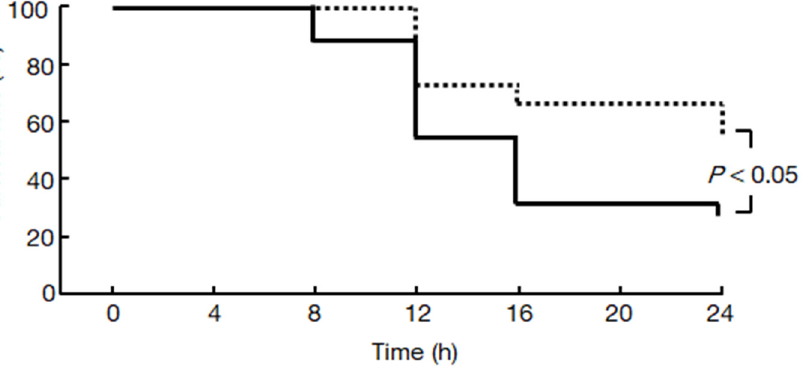
Figure 7. Effect of TY-51469 on the survival rate. Cumulative percent survival rate in the placebo (solid line)- and TY-51469 (dotted)-treated groups after the injection of L-arginine (placebo-treated group: n = 25, TY-51469-treated group, n = 25). The difference between the placebo- and TY-51469- treated groups is significant (Kaplan–Meier analysis followed by the log-rank test, p < 0.05).